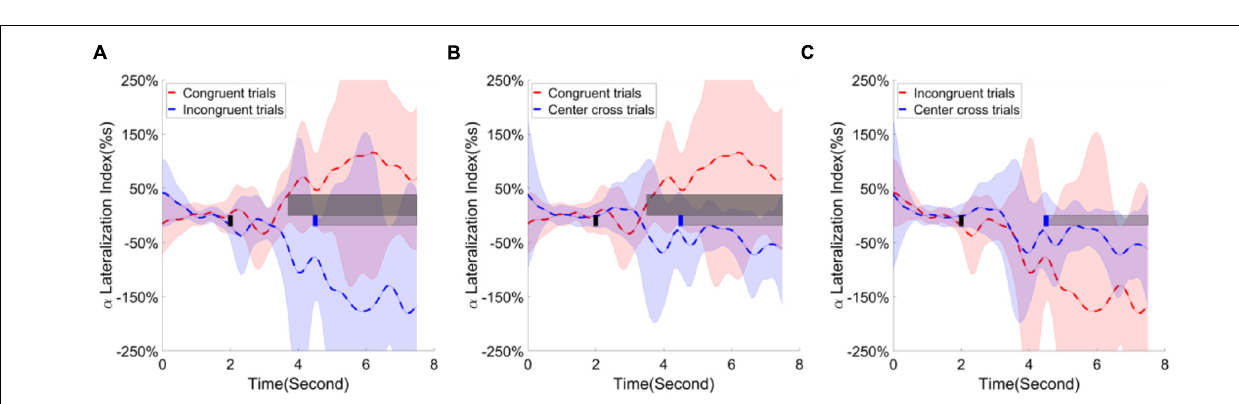
FIGURE 11 | Group average alpha lateralization index across the time in the parietal occipital area. Shaded areas represented the stand error of a lateralization index. The target cue appeared at the end of second 2, which was indicated by a short black bar. The cursor feedback began at the second of 4.5, which was marked by a short blue bar. The light gray bar represented the feedback period. The dark gray bar demonstrated the period of significant difference. Contrast analysis of lateralization process in the parietal occipital area between (A) congruent trials and incongruent trials, (B) between congruent trial and center cross trials, (C) between incongruent trials and center cross